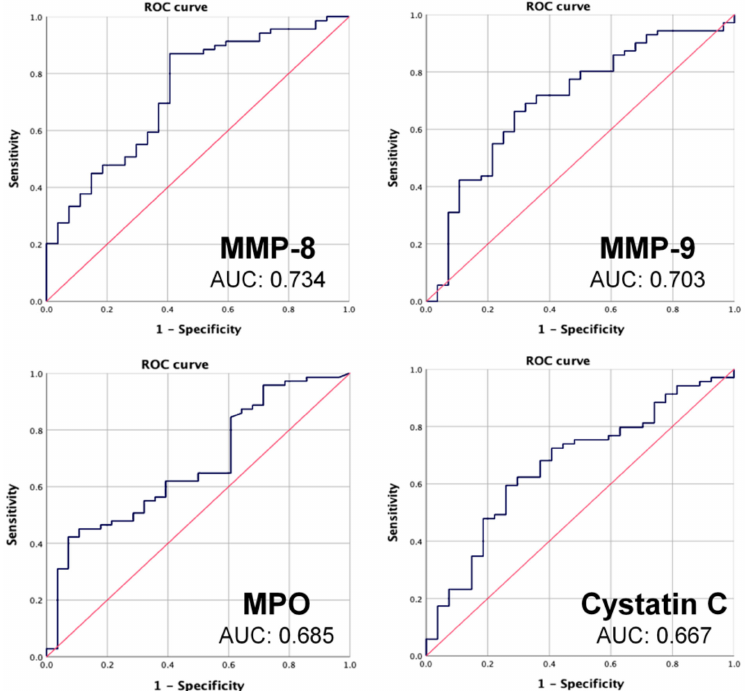
Figure 3. Receiver operating characteristic (ROC) curve of MMP-8, MMP-9, MPO, and cystatin C. Area under ROC curve (AUC) is measured based on the curve. The farthest point from standard line is selected to set cut-o ff value for diagnosis. MPO, myeloperoxidase; MMP-8, matrix metalloproteinase-8; MMP-9, matrix